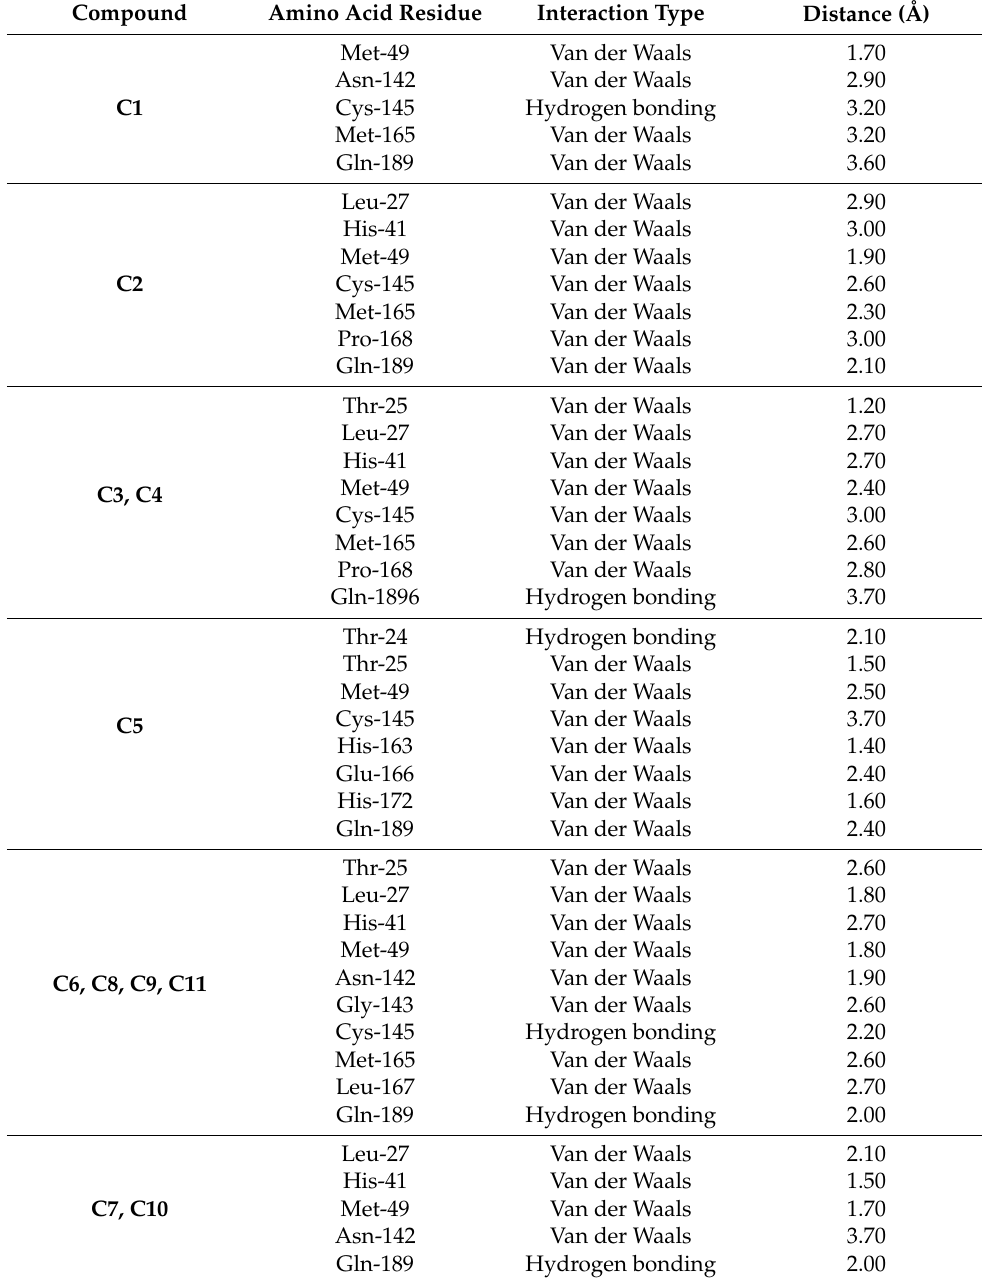
Table 2. Molecular docking results for the interaction between M pro : C1 – C17